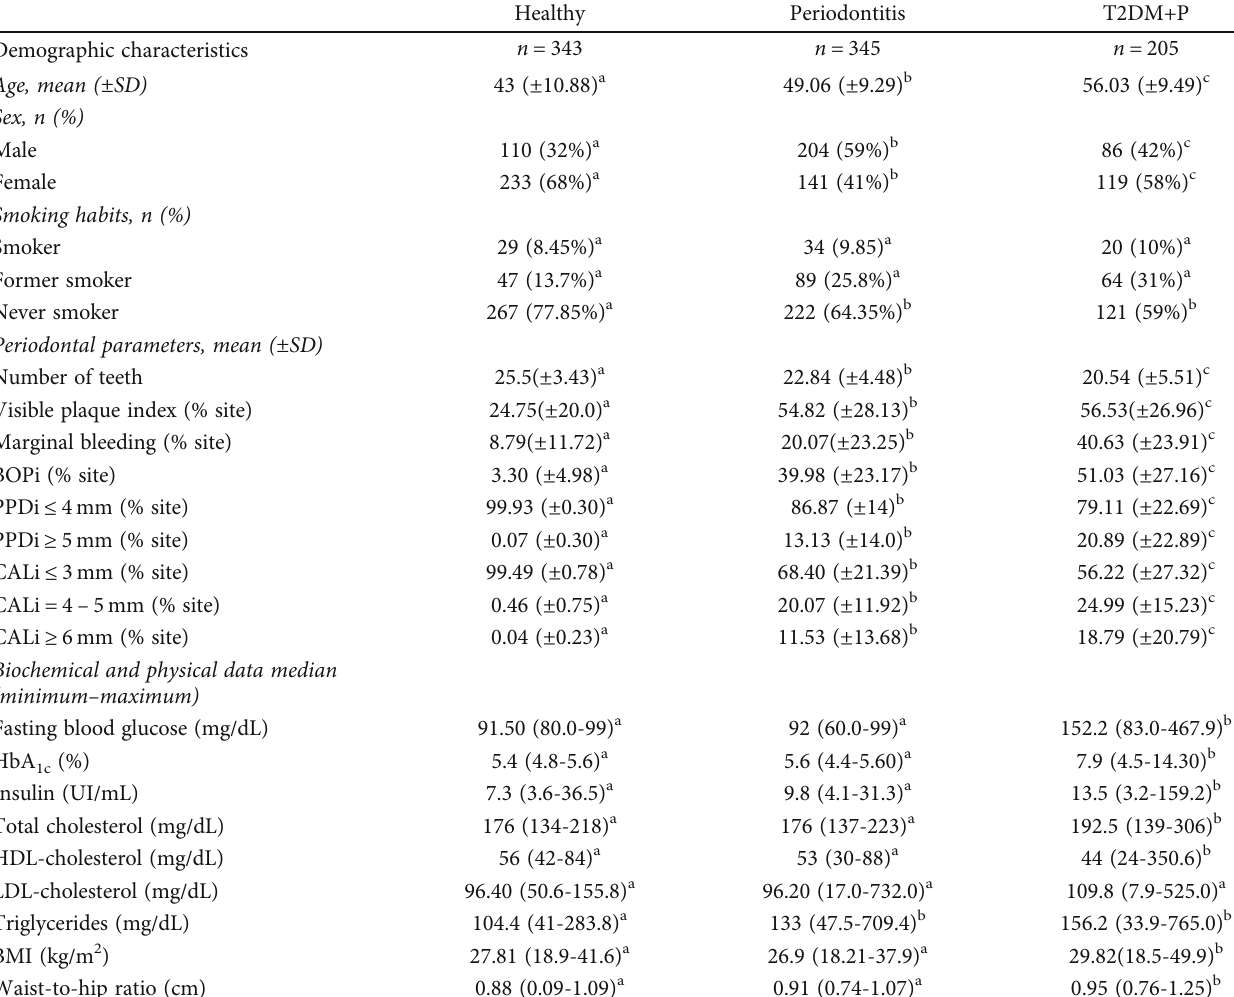
Table 2: Demographic characteristics of the studied groups, clinical periodontal parameters, glycemic and lipid pro fi les, and physical exams of all